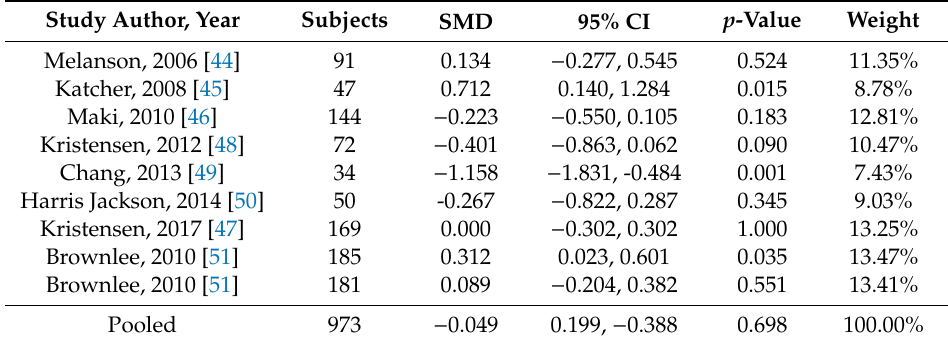
Table 2. Random e ff ects meta-analysis model of 9 trials assessing relationship of WG interventions on weight change (kg) 1,2